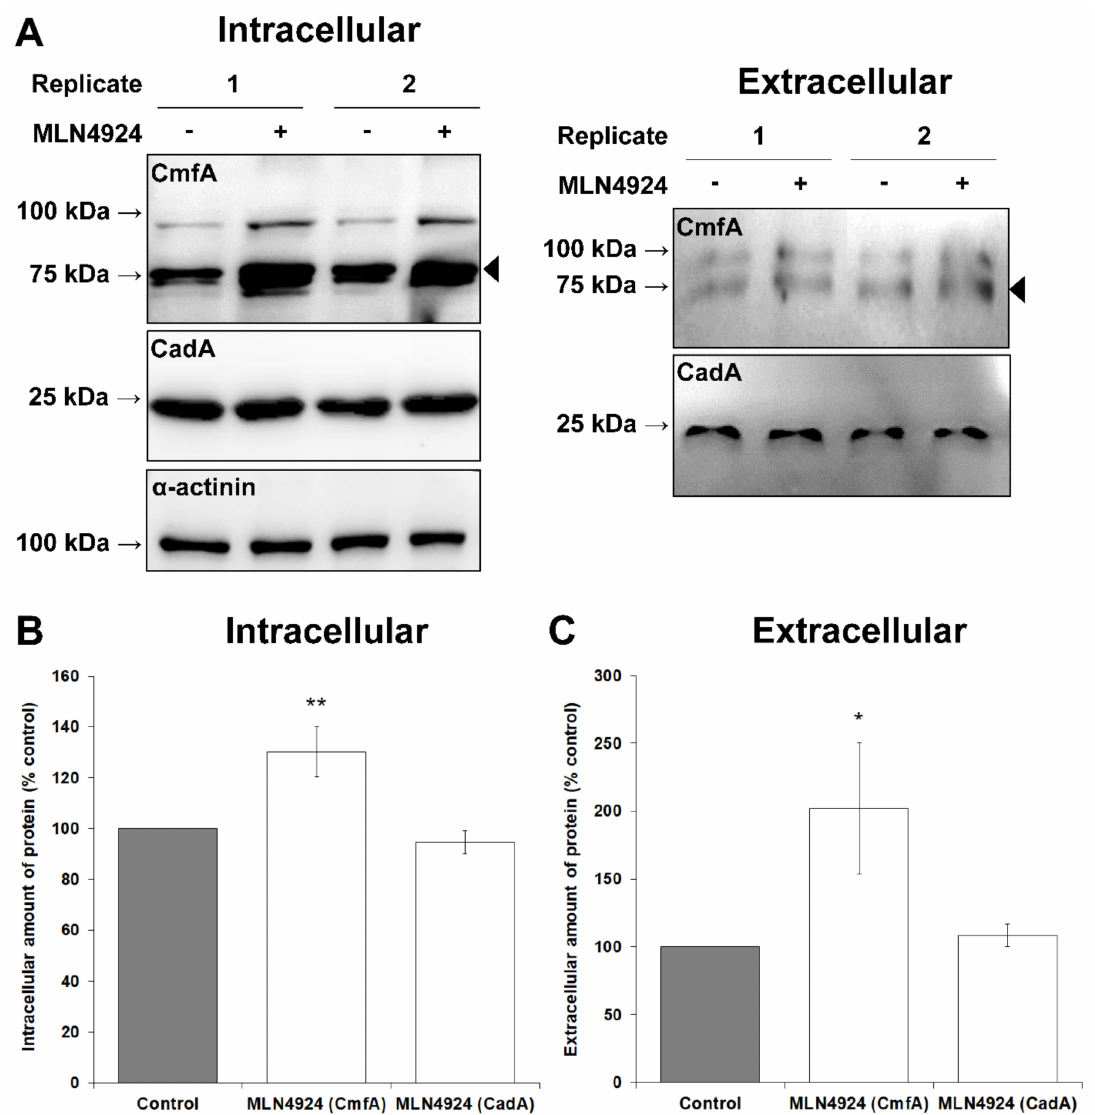
Figure 6. Effect of MLN4924 on the intracellular and extracellular amounts of conditioned media factor (CmfA) and calcium-dependent cell adhesion molecule A (CadA). ( A ) Cells were starved in KK2 buffer in the presence and absence of MLN4924 (50 µ M, control: dimethyl sulfoxide) for 6 h, after which time the conditioned buffer was collected and cells were lysed. Whole cell lysates (WC, 50 µ g total protein) and equal volumes of conditioned buffer (CB, 15 µ L) were separated by SDS-PAGE and analyzed by Western blotting with anti-CmfA, anti-CadA, and anti- α -actinin (loading control). Two representative biological replicates are shown. Molecular weight markers (in kDa) are shown to the left of each blot. The bands corresponding to CmfA are indicated with a black arrow to the right of each blot. ( B ) CmfA and CadA protein bands in whole cell lysates were quantified and standardized against the amount of α -actinin. Data presented as mean intracellular amount of protein (% control) ± SEM ( n = 32). ( C ) CmfA and CadA protein bands in samples of conditioned buffer were quantified. Data presented as mean extracellular amount of protein (% control) ± SEM ( n = 12). Statistical significance in ( B ) and ( C ) was assessed using the one-sample t -test. * p < 0.05 and ** p < 0.01 vs.